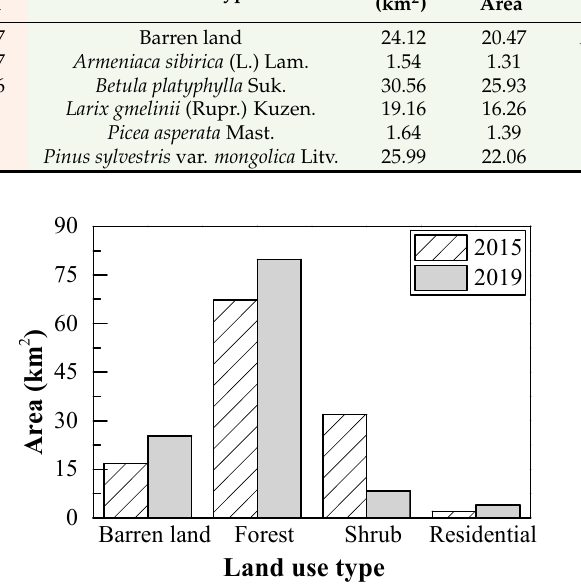
Figure 2. The land use map of the study area in ( a ) 2015 and ( b ) 2019. Corresponding to the land use map in Figure 2a,b, the area proportions of different land use types in 2015 and 2019 were shown in Table 1. Table 1. The area proportion of each land use type in 2015 and 2019 corresponding to Figure 2a,b.